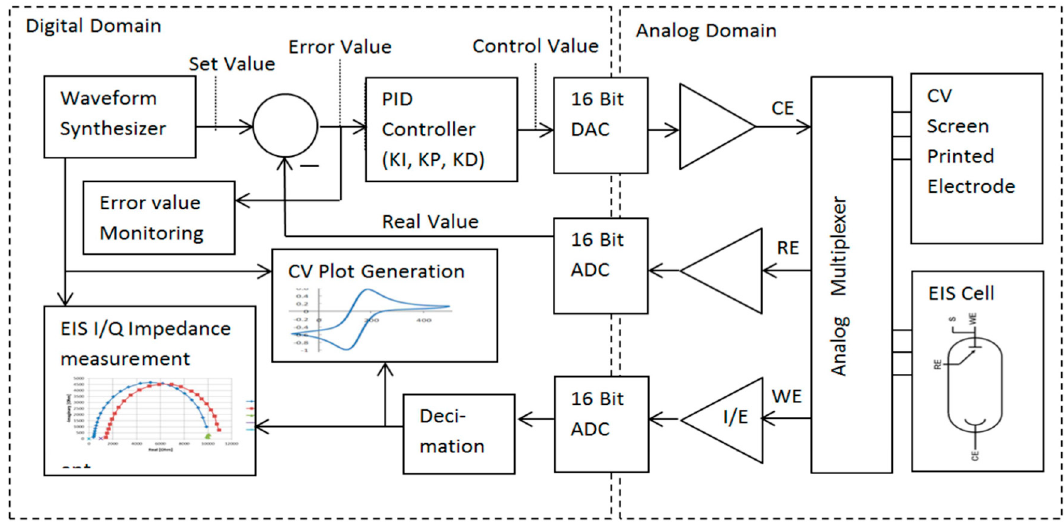
Figure 1. Block diagram of the multiple pathogen detection platform comprising the EcoStat device.